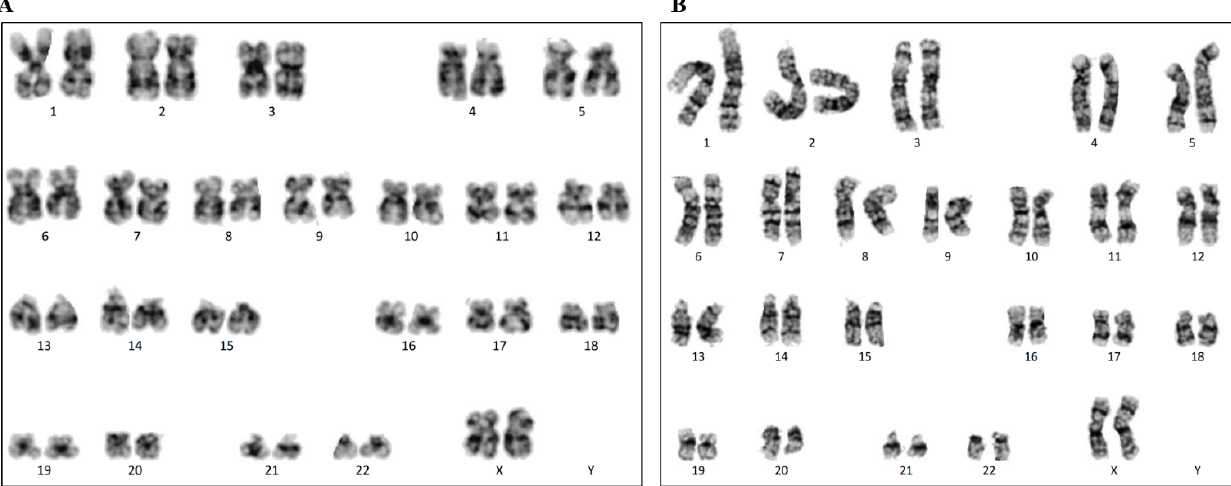
Figure 6. Karyotyping of H9 hESCs p55 after ten passages cultured in homemade E8 medium containing hFGF-2 ( A ) or hDJ-1 ( B ).